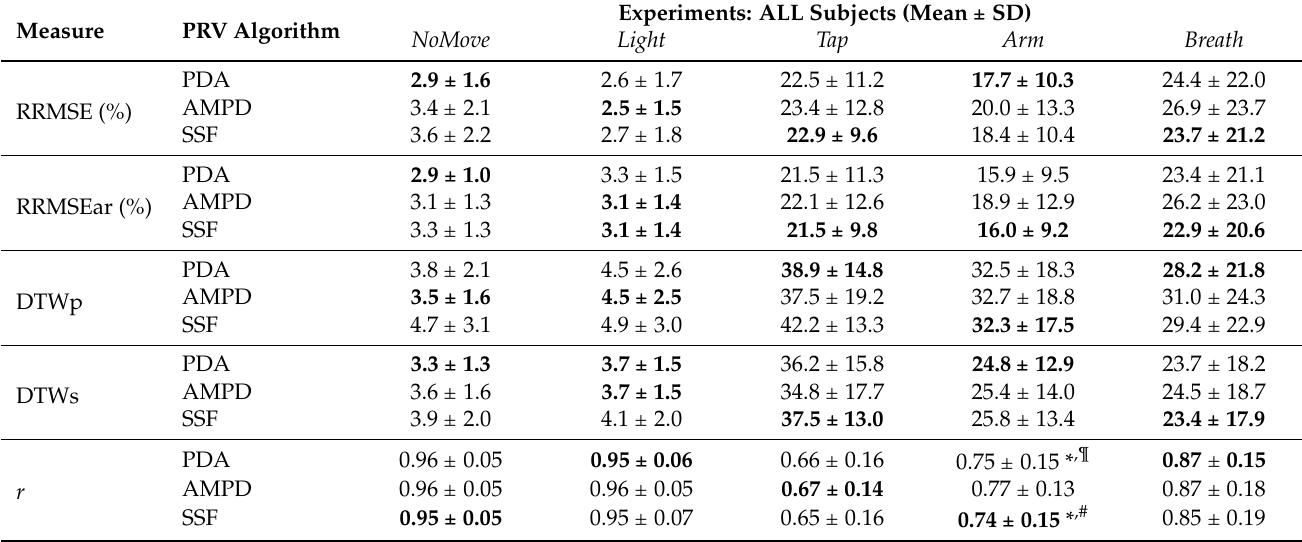
Table 2. Similarity measures of HRVs and PRVs obtained from simultaneous ECG and PPG (averaged over ALL subjects): RRMSE—relative RMSE before AR modeling, RRMSEar—relative RMSE after AR modeling, DTWp—Dynamic Time Warping before entire post-processing, DTWs—Dynamic Time Warping after outliers correction, r —Pearson’s correlation coefficient after entire post-processing. The symbols #, *, or ¶ indicate that a given value is statistically smaller than for PDA, AMPD, and SSF, respectively, verified with the Student’s t -test at the 5% significance level.